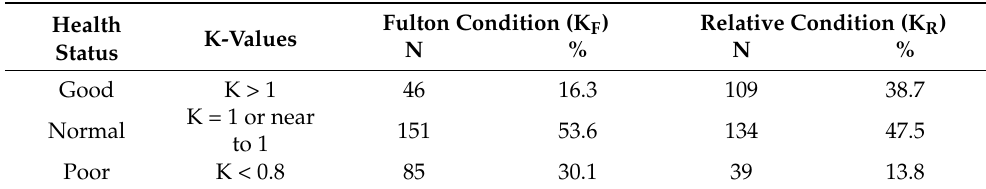
Table 3. Health status of rescued Chinese pangolin based on the Fulton condition (K F ) and relative condition (K R ) factors.